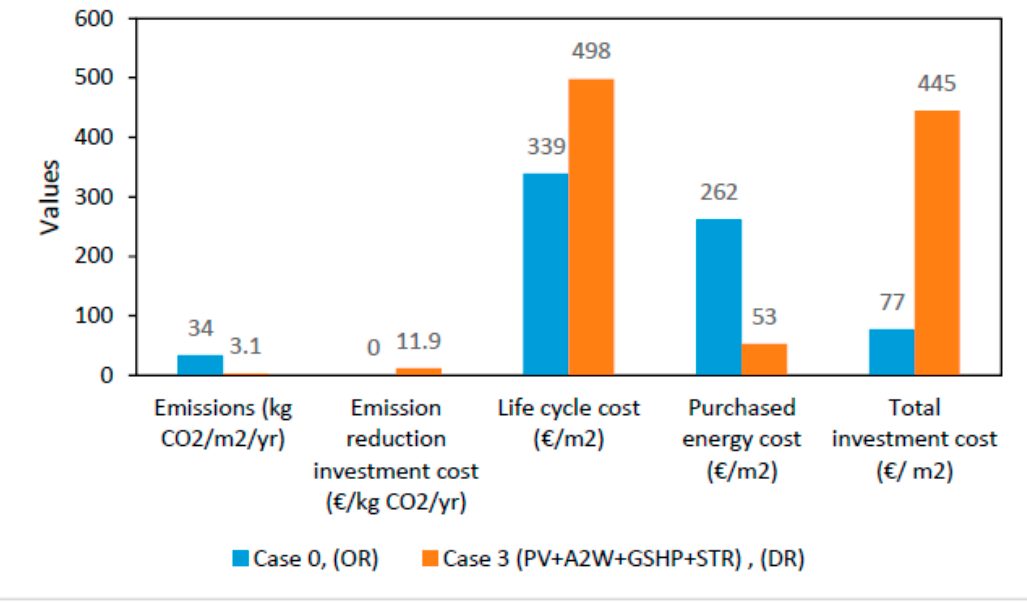
Figure 15. The emissions, emissions reduction cost, LCC, investment, and purchased energy cost comparison between Case 0 with OR buildings and Case 3 with DR buildings in the community.